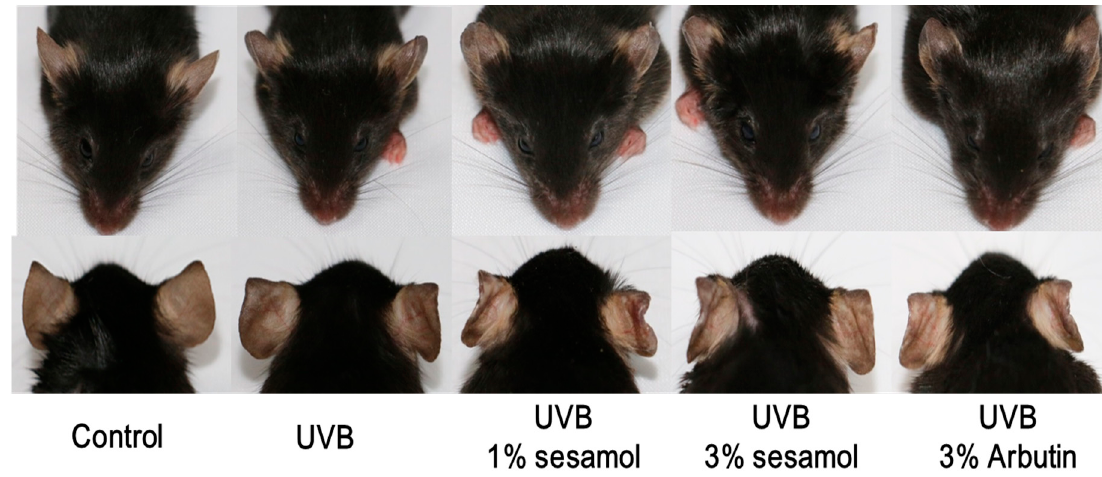
Figure 5. Photographs illustrate the skin lightening effect of sesamol after topical application for 4 weeks on UVB-irradiation-induced hyperpigmentation in C57BL/6 mice.